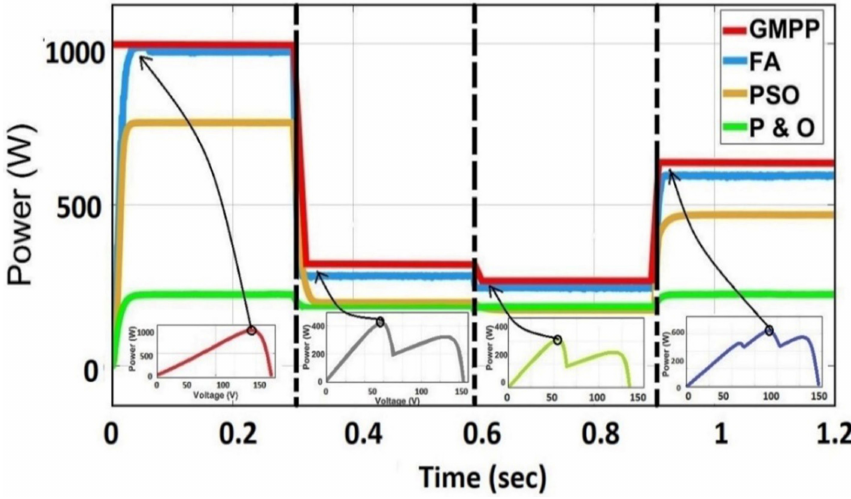
Figure 46. FA, PSO, P&O under varying Irradiance and